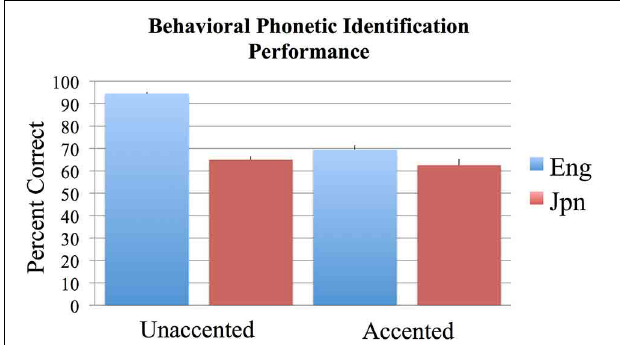
FIGURE 1 | Mean percent correct behavioral phonetic (/r/ vs. /l/) identification performance for the English (blue) and Japanese (red) groups for unaccented and foreign-accented speech. Standard error of the mean is given above each bar. All conditions were significantly above chance performance of 50%. See text for additional contrasts that were statistically